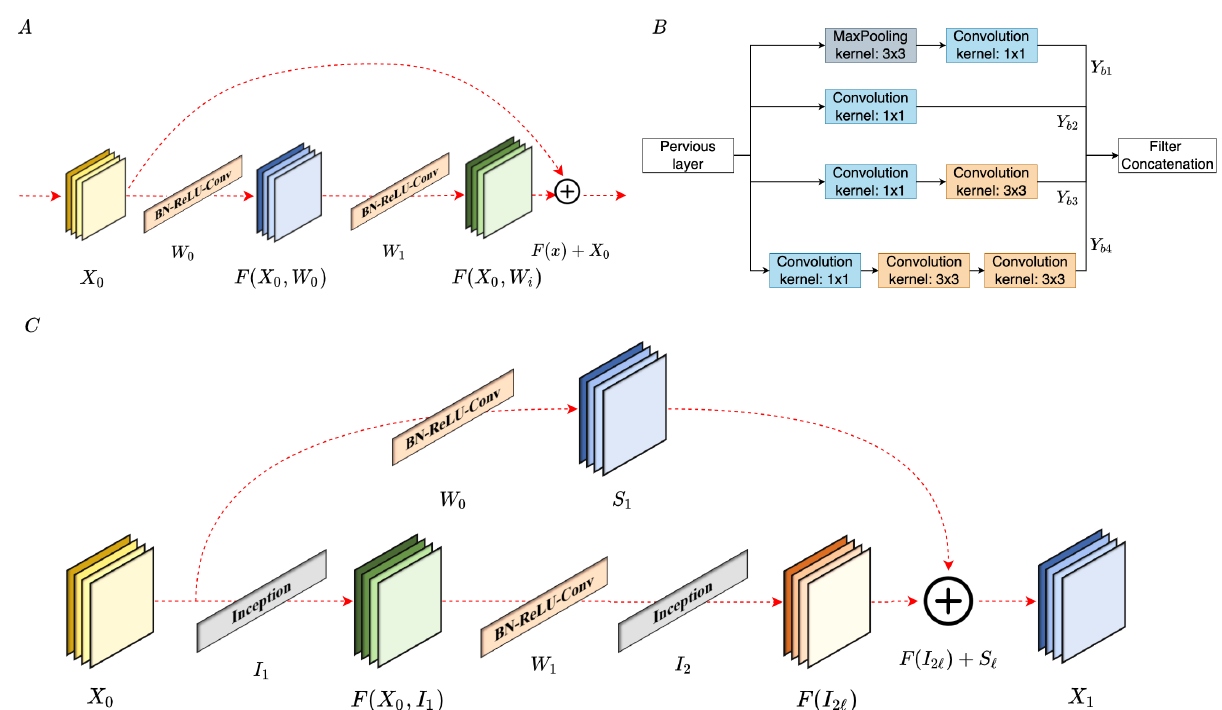
Figure 5. ( A ) Residual connectivity. ( B ) Inception block. ( C ) Residual-Inception block. ( A , B )